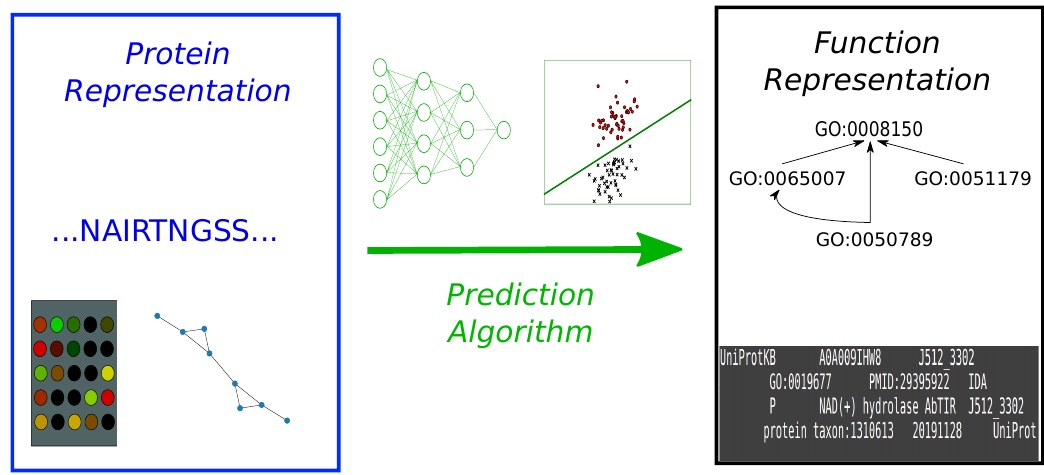
Figure 1. AFP algorithms typically consist of a protein representation (protein sequence, expression data, biological networks) (left, in blue), a function representation (often a vector of one-hot encoded GO terms) (right, in black) and a prediction algorithm that connects both (neural networks, support vector machines, Guilt-By-Association methods etc.) (middle, in